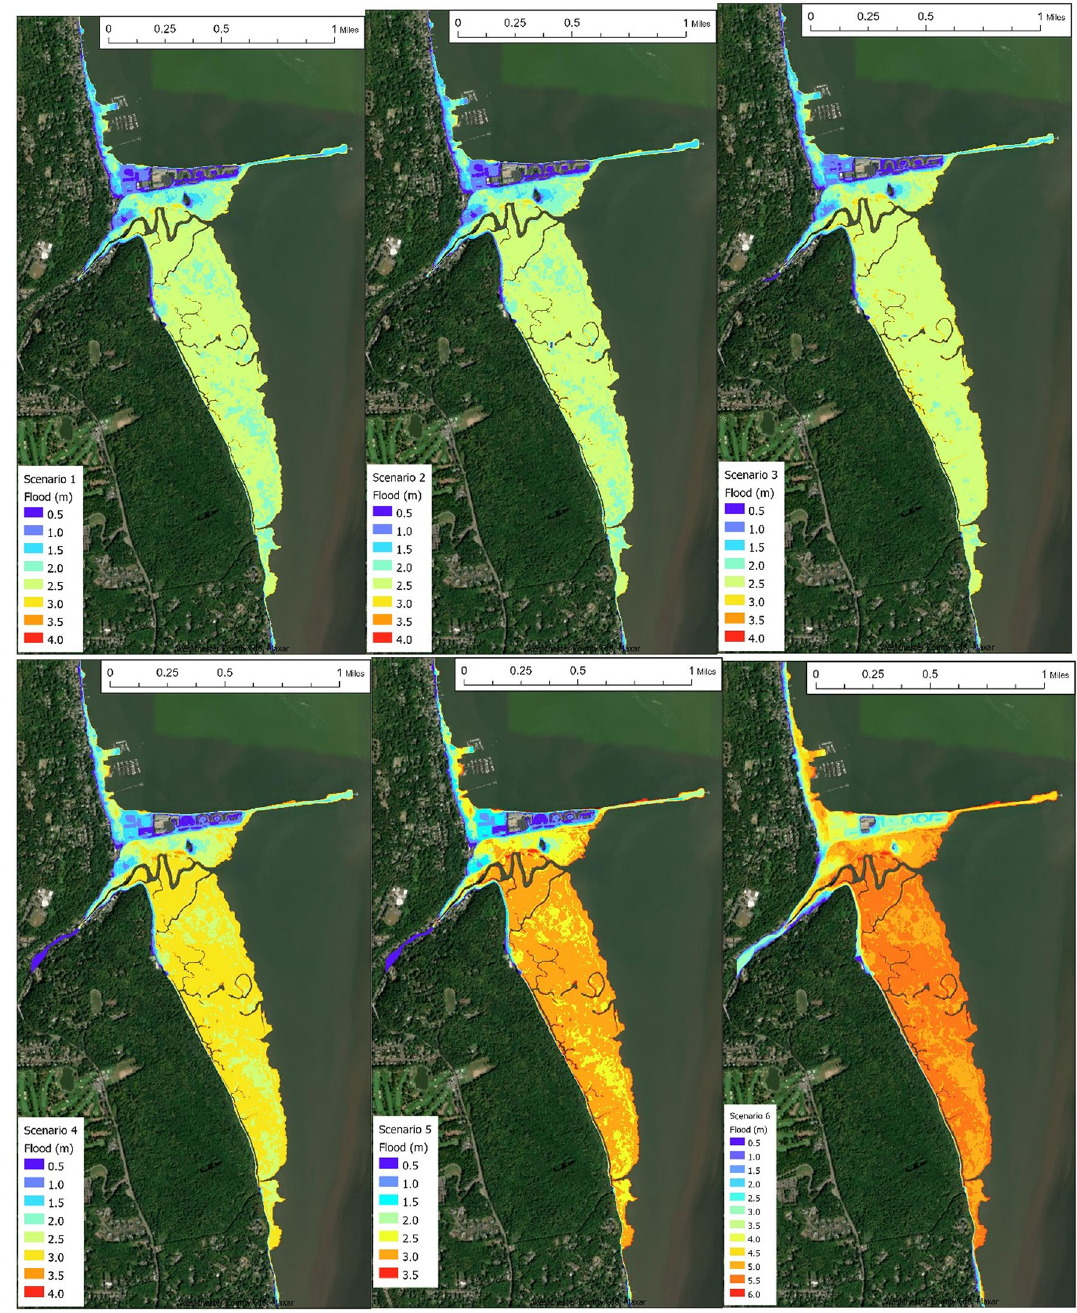
Figure 3. 1% Annual chance flood maps of Piermont, NY for the six scenarios shown in Table 1. Top panel— Scenario 1,2,3 (left to right); lower panel—Scenario 4,5,6. (ArcGIS basemap credit: Westchester County GIS,